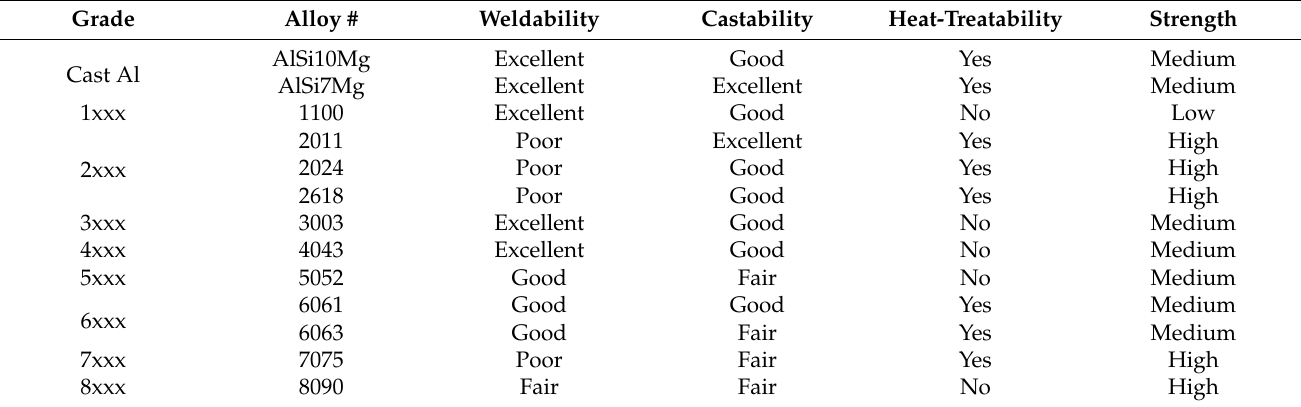
Table 2. Properties and performances of typical compositions in each Al category